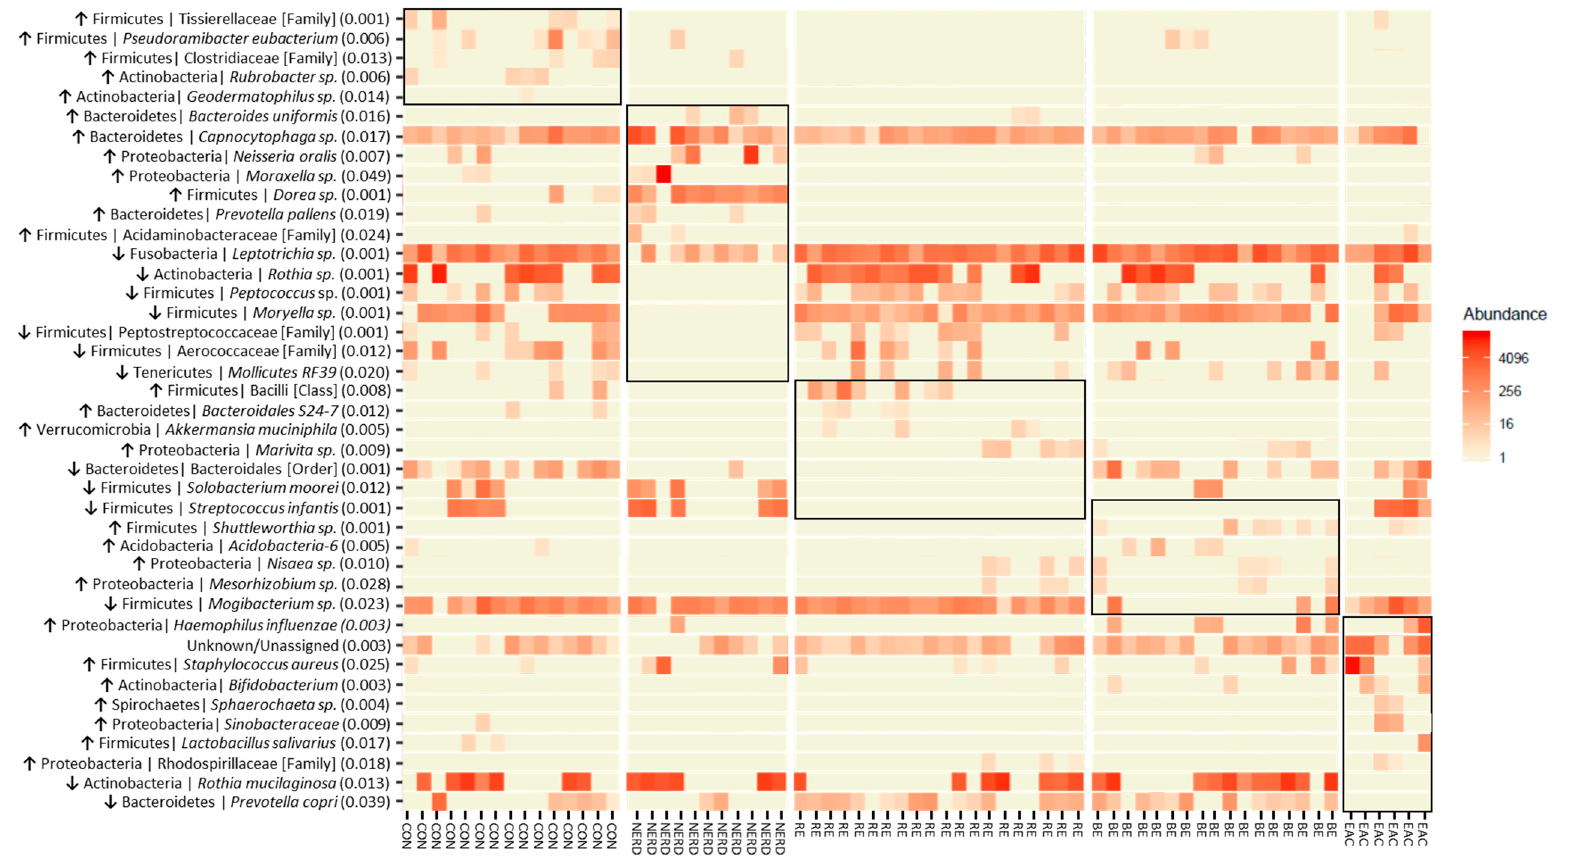
Figure 2. Heatmap representation of 41 di ff erential operation taxonomic units (OTUs) between control (CON; n = 16) and disease phenotypes (non-erosive reflux disease (NERD; n = 11), reflux esophagitis (RE; n = 20), Barrett’s esophagus (BE; n = 17), and esophageal adenocarcinoma (EAC; n = 6)). OTUs from each disease phenotype were compared by multivariant analysis (anova.manyglm; p -value < 0.05). p -values are shown in brackets ( ), taxa classified above genus level are denoted in [ ]. Pairwise analysis identified di ff erences in OTU associated with specific disease phenotype(s), these markers are grouped by black outlines. Trend-of-change for each marker within the phenotype is indicated with an arrow.